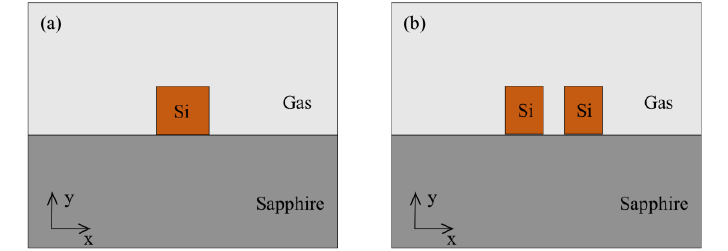
Figure 1. A cross-section schematic diagram of the proposed SOS-based structure ( a ) strip waveguide; ( b ) slot waveguide.